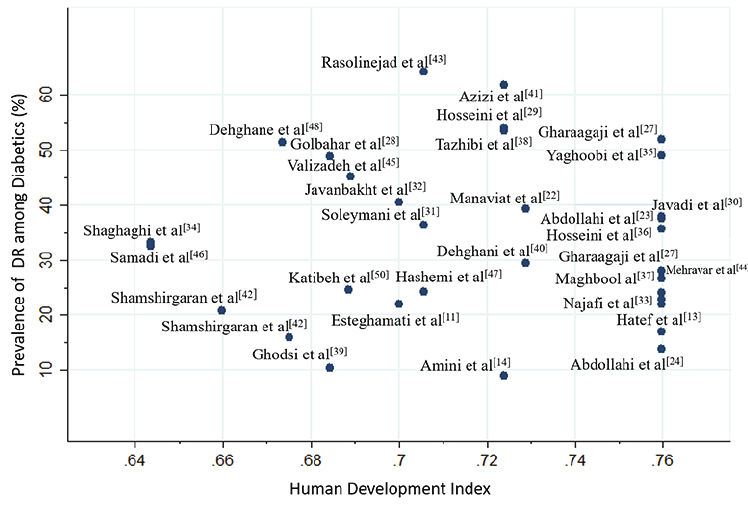
Figure 4. Scatter plot of the linear correlation of prevalence and the Human Development Index. DR, diabetic